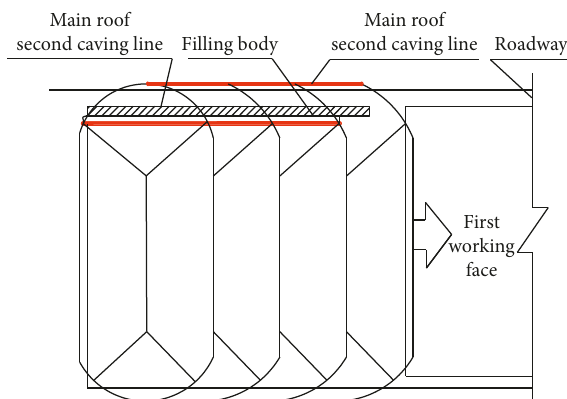
Figure 2: Diagram of destruction of the main roof in gob-side entry